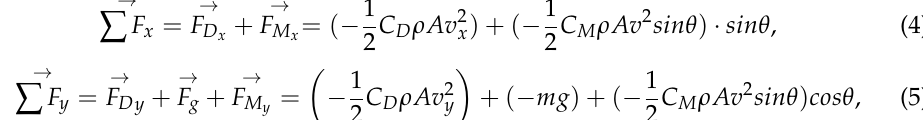
Figure 4. Schematic of the baseball flight at ( a ) 𝑡 (cid:2869) and ( b ) 𝑡 (cid:2870) .